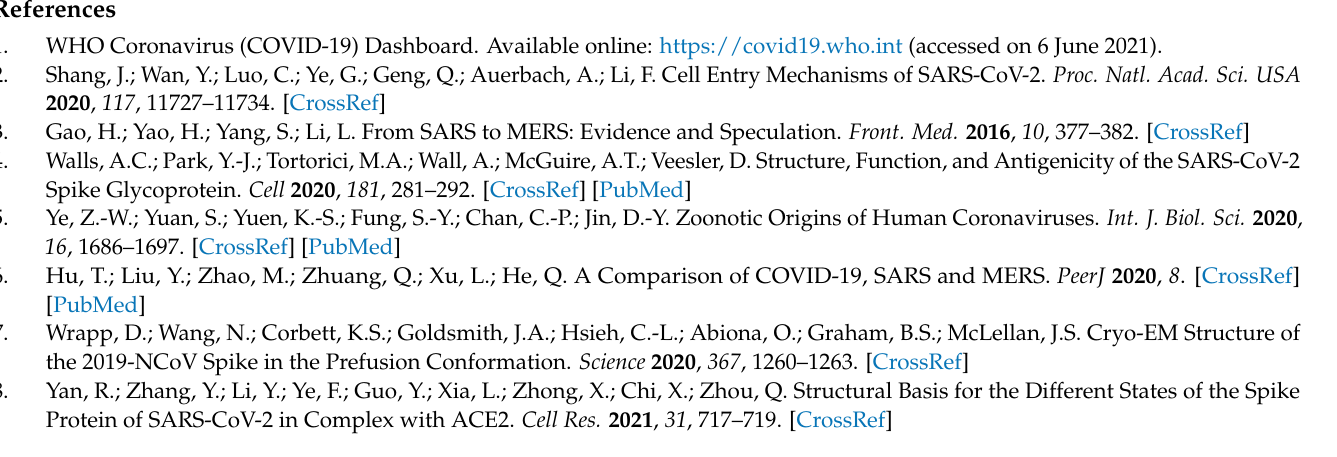
(DSSP), Figure S4: Number of hydrogen bonds, Figure S5: Ramachandran plot, Figure S6: ProSA analysis, and Figure S7: Verify3D